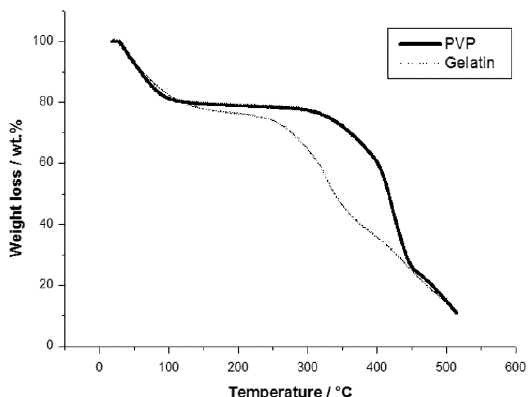
Figure 7. Thermogravimetric curves (TGA) of pure gelatin and pure PVP.